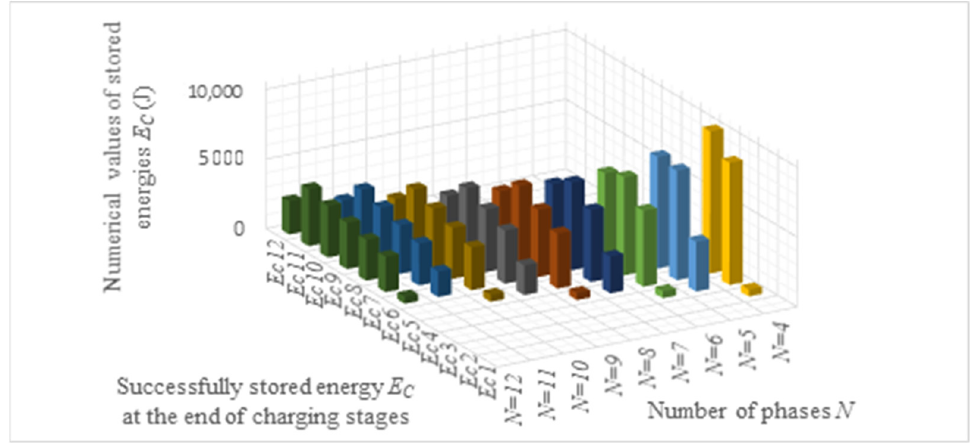
Figure 15. Energies stored in SC circuit during the operations of certain duty cycles at different numbers of phases.